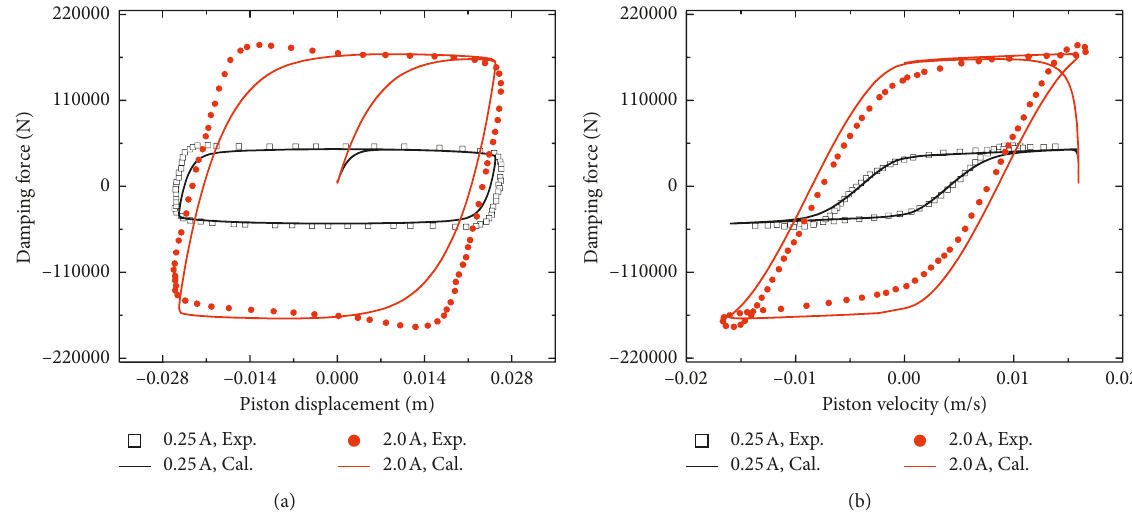
Figure 14: Model predictions (lines) and experimental data (Yang [34]) of hysteretic behavior of MR dampers under sinusoidal dis- placement excitations of 0.254cm, 1 Hz. (a) Displacement-force hysteresis. (b) Velocity-force hysteresis.